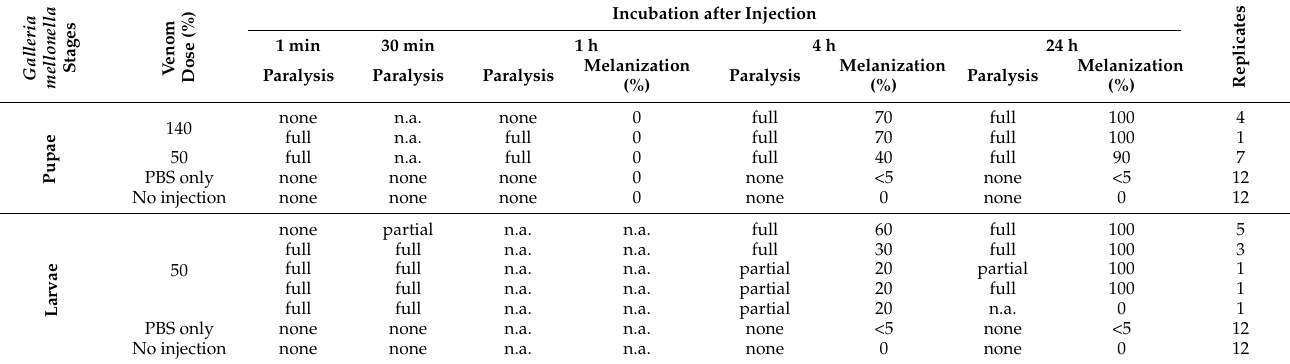
Table 1. Effect of Rhynocoris iracundus venom on Galleria mellonella . G. mellonella larvae and pupae were injected subcuta- neously with low (50%) and high (140%) venom doses. Paralysis and melanization observations were recorded from 1 min until 24 h post injection.